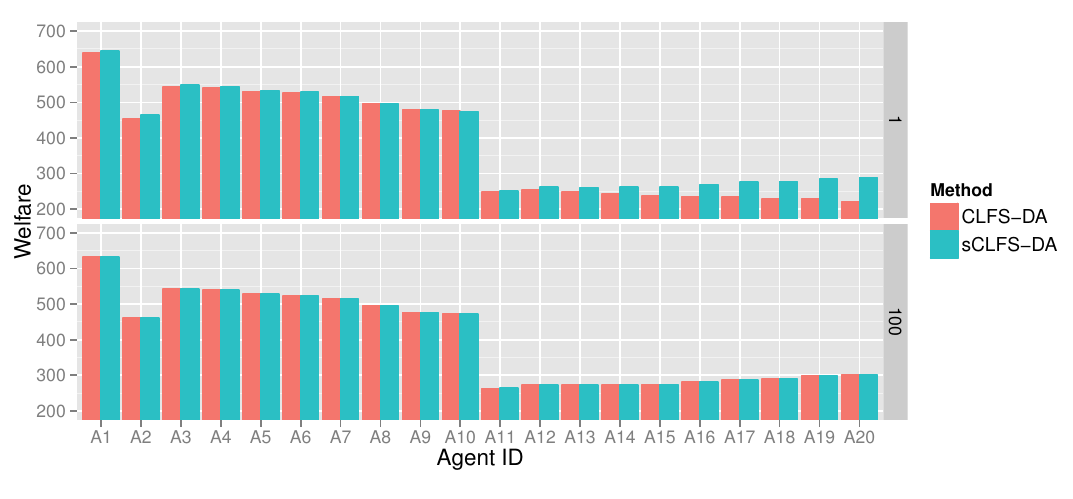
Figure 6. Individual welfare of each agent after the first iteration ( top ), and after the 100-th iteration ( bottom